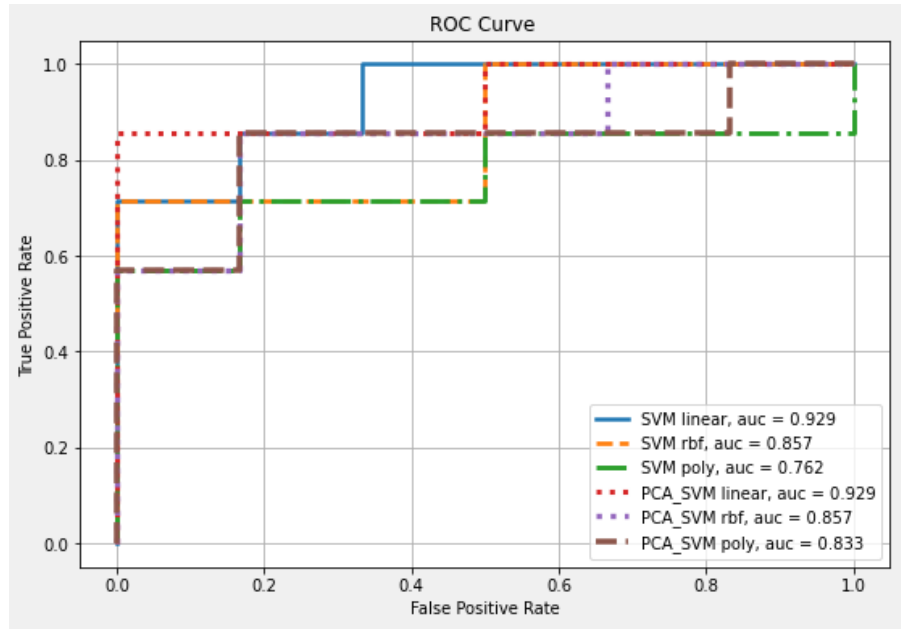
Table 3. Thirty-two parameter set to predict CDR-SB deterioration.